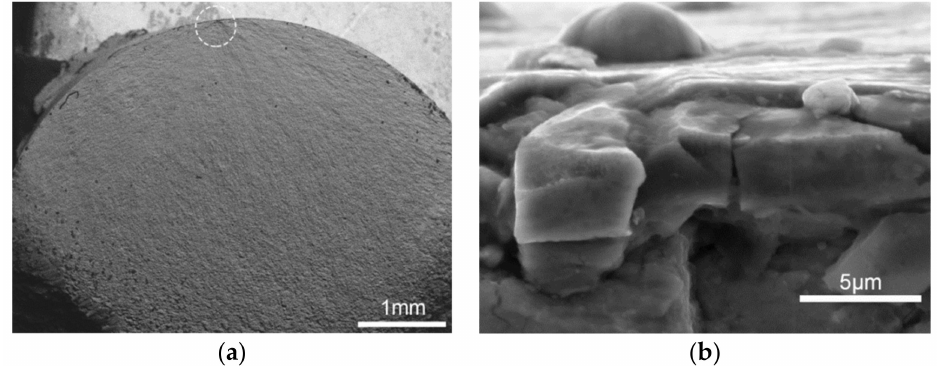
Figure 11. Fracture surface of the TiN coated sample σ = 650 MPa, 99619 cycles. ( a ) Macroscopic morphology of fracture surface, ( b ) coating crack morphology in the white dashed circle of ( a ) at high